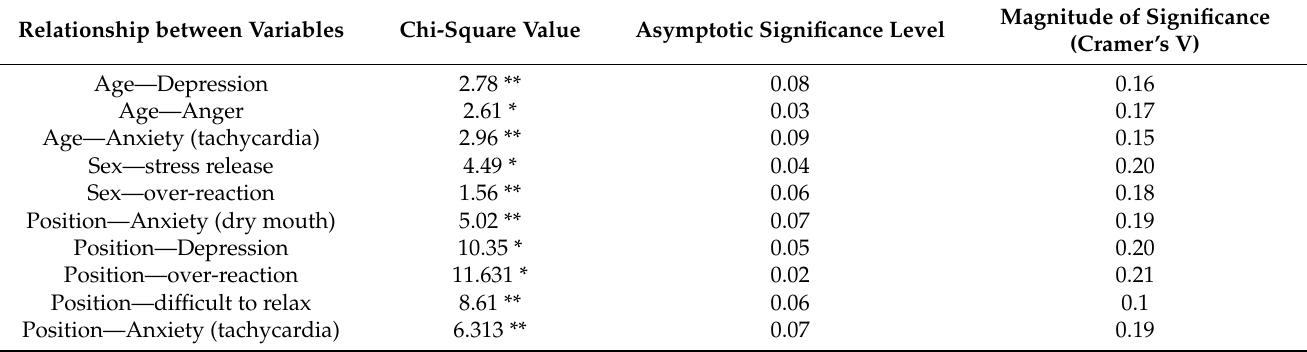
Table 3. Significance levels according to the chi-square statistic in the relationship between variables.